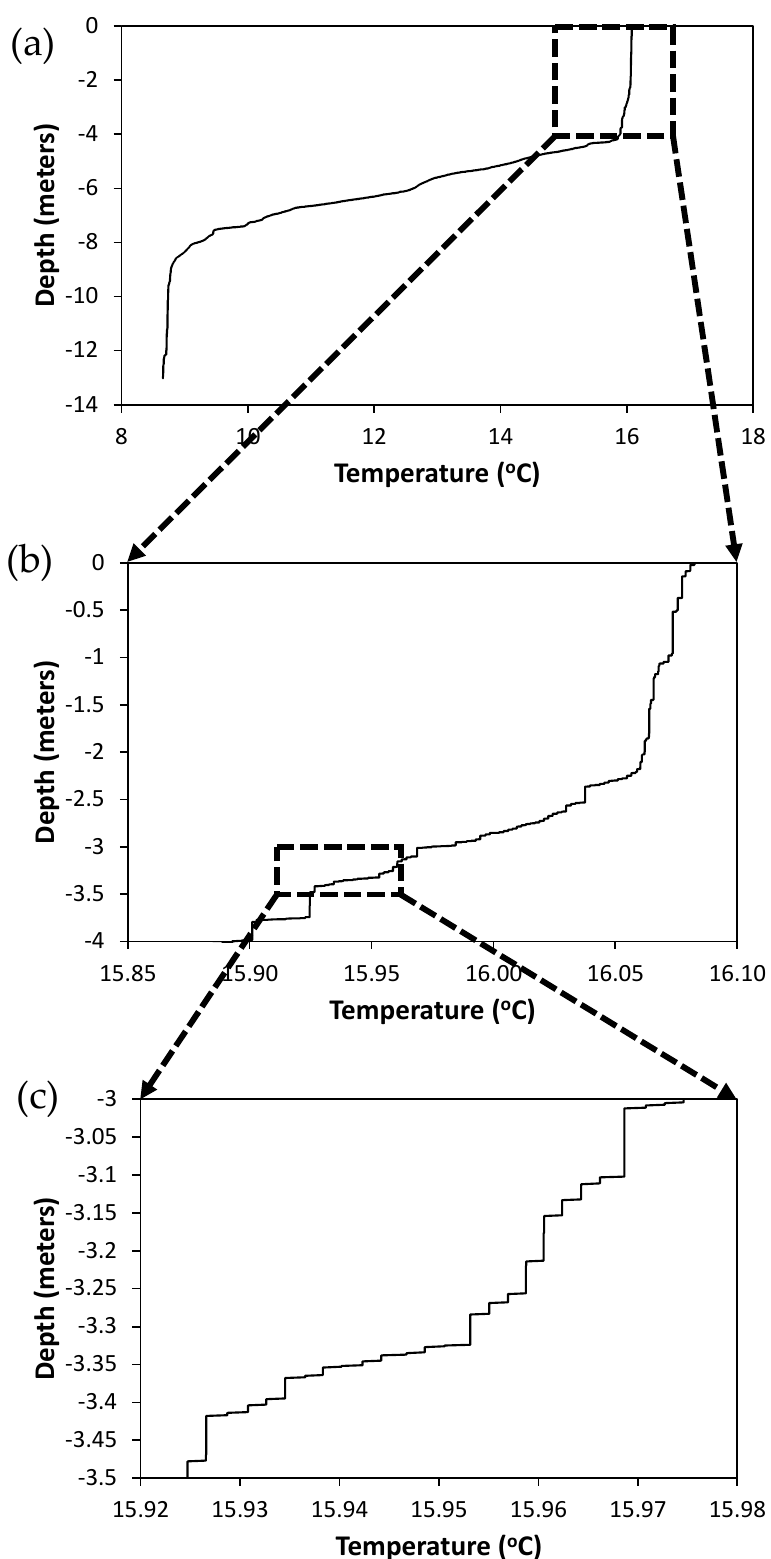
Figure 1. Example of the multi-scale layering structure in thermal microstructure profiles (profile recorded in Blelham Tarn at 11:00 on 11 August 2008): ( a ) full-depth profile; ( b ) zoomed into top 4 m; ( c ) zoomed into 3–3.5 m below surface. See Figure 2 and associated text for explanation of the “chunkiness” in the fine structure shown here.